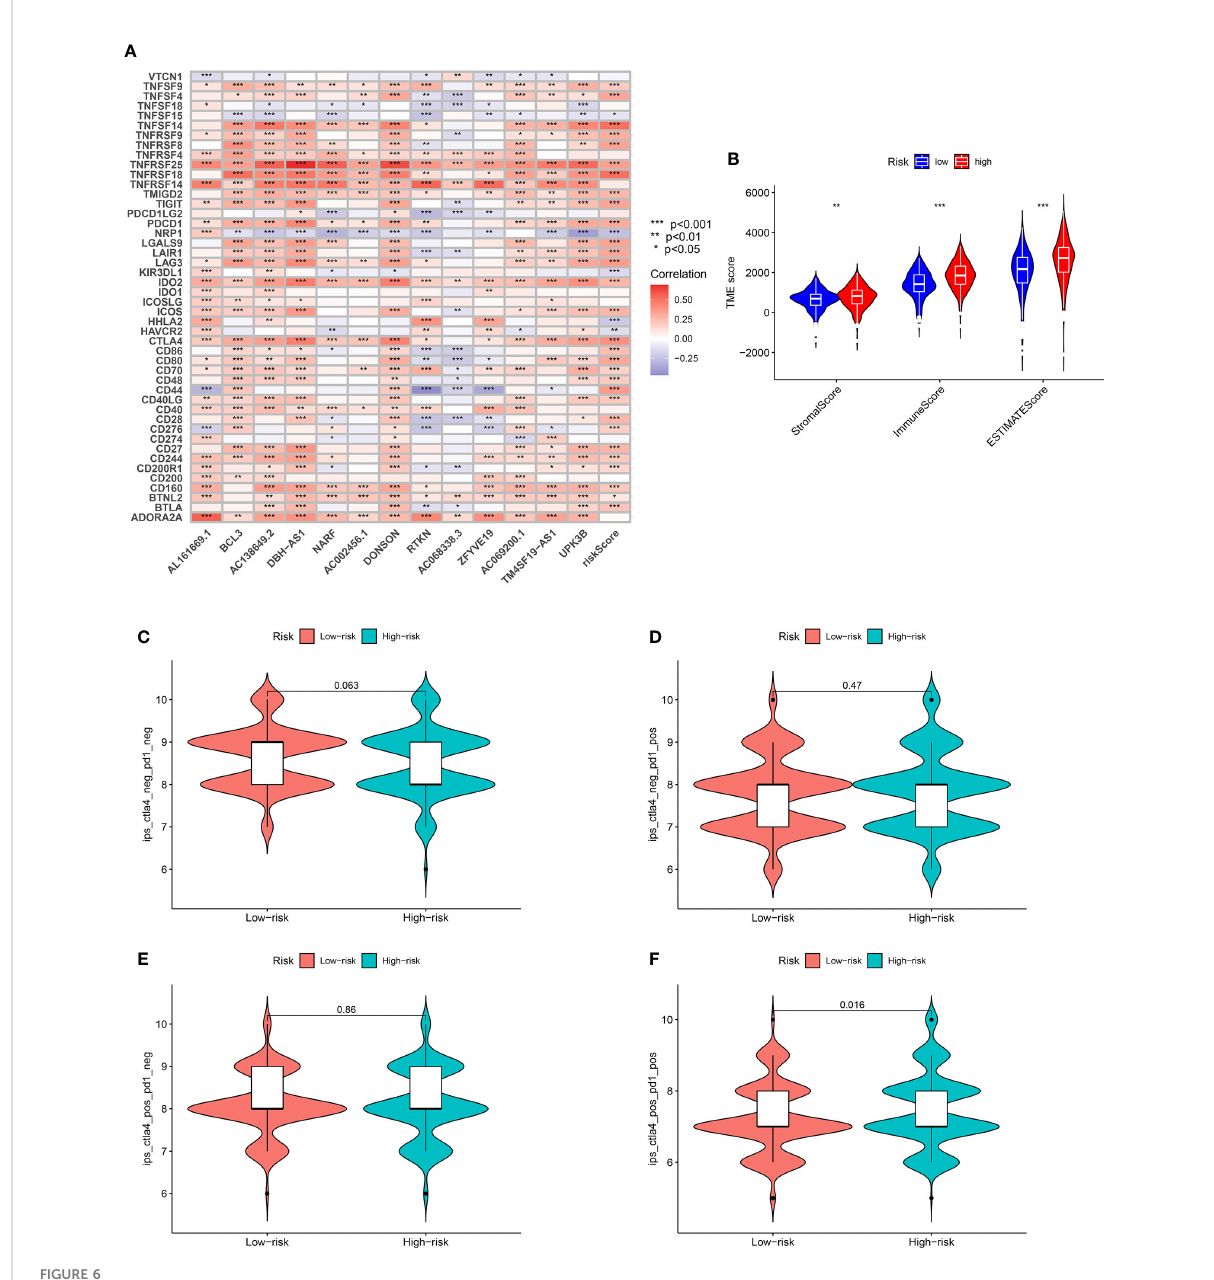
FIGURE 6 (A) Signi fi cant differences identi fi ed in the expression levels between immune checkpoint subtypes and prognostic-related genes. (B) TMB score analysis between high- and low-risk groups. (C) Immunotherapy evaluation of CTLA4 negative and PD1 negative patients between low- and high-risk groups. (D) Immunotherapy evaluation of CTLA4 negative and PD1 positive patients between low- and high-risk groups. (E) Immunotherapy evaluation of CTLA4 positive and PD1 negative patients between low- and high-risk groups. (F) Immunotherapy evaluation of CTLA4 positive and PD1 positive patients between low- and high-risk groups. *** P < 0.001; ** P < 0.01; * P <